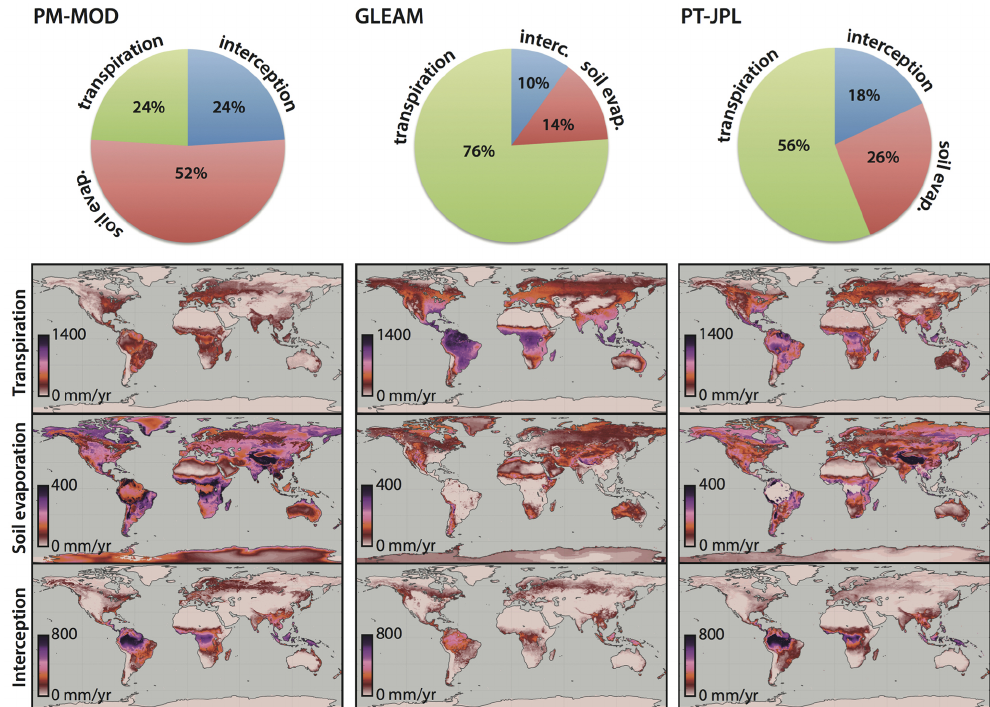
Figure 12. Partitioning evaporation. Maps indicate the average (2005–2007) transpiration, interception loss, and bare-soil evaporation for each of the three WACMOS-ET models. Pie diagrams illustrate the global average contribution to total land evaporation from each component and